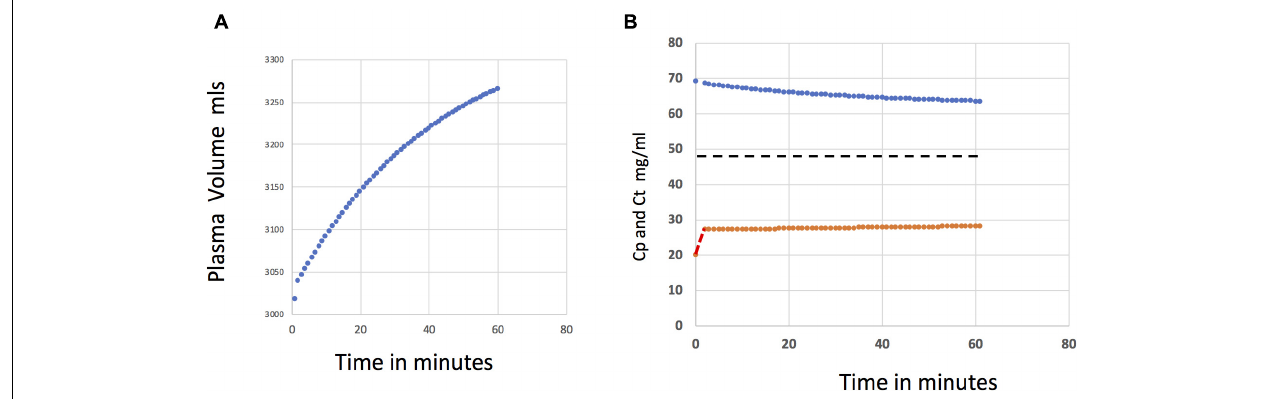
FIGURE 4 | (A) Plasma volume is shown as a function of time during reabsorption after capillary pressure reduced from 20 to 13 mmHg. The rate of reabsorption predicted using models Model 1a scaled for skeletal muscle ( Figure 2 ) is a maximum because protein accumulation in the fluid behind the glycocalyx cannot exceed with concentration of the ISF in the tissue sub-compartment (volume 1,000 ml). (B) The protein concentrations in in vascular space ( Cp ) (blue) is reduced as reabsorbed fluid is added to the vascular volume. The tissue protein concentration Ct increases slowly as protein flux through large pores accumulates in the tissue sub-compartment. It takes many hours for the protein concentration in the tissue compartment to reach the steady state concentration for pressure of 13 mmHg (broken black